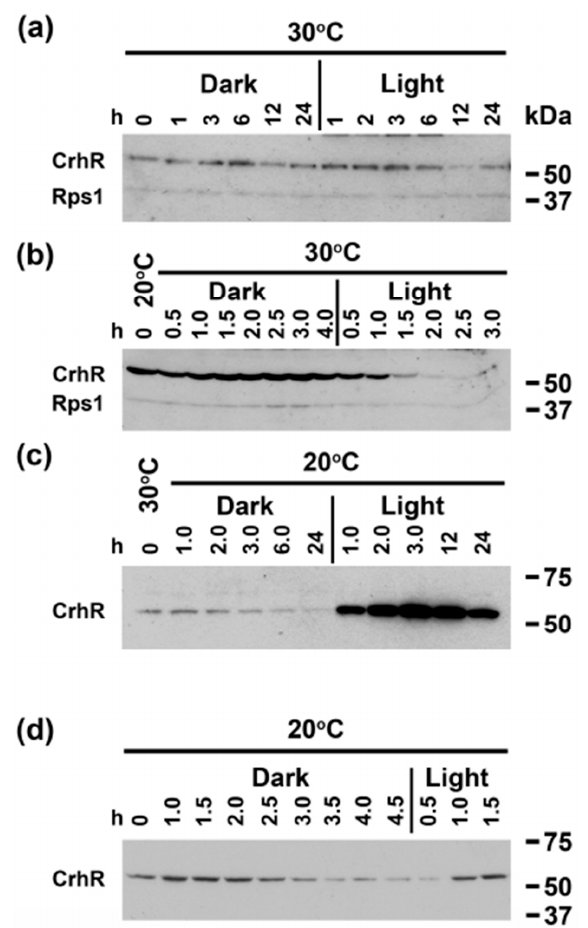
Figure 3. Effect of temperature shift and light-dark transition on CrhR accumulation. A Synechocystis culture was grown to mid-log phase under standard light conditions at 30 °C and aliquots subjected to the following treatments before determination of CrhR accumulation by Western blot analysis. ( a ) Cells were transferred to dark conditions at 30 °C for 24 h and subsequently exposed to light at 30 °C for 24 h. Cells were sampled at indicated times. ( b ) Cells were pre-induced for maximal CrhR accumulation for 3 h at 20 °C (T = 0) and then transferred to the dark at 30 °C for 4.5 h. The culture was then exposed to light for 3 h at 30 °C. Cells were sampled at indicated times. For ( a , b ), Western blots were simultaneously probed with antibodies against CrhR (55 kDa) and E. coli ribosomal protein S1 (Rps1, 40 kDa) which was used as a control for protein loading. ( c ) Cells were shifted simultaneously to the dark and 20 °C for 24 h and then exposed to light at 20 °C for 24 h. Cells were sampled at indicated times. ( d ) Cells were pre-induced for maximal CrhR accumulation for 3 h at 20 °C (T = 0) and then transferred to the dark at 20 °C for 4.5 h. Cells were subsequently transferred to the light at 20 °C for 1.5 h. Cells were sampled at indicated times. CrhR protein abundance was determined by Western blotting, as described in Figure 1.